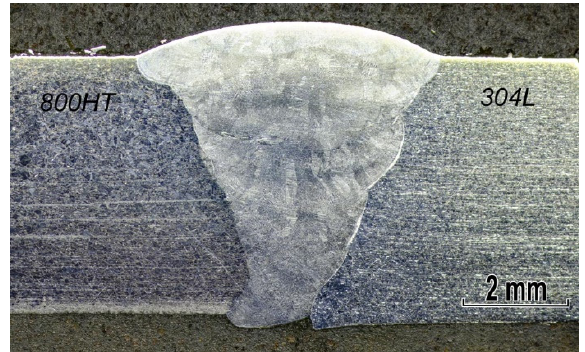
Figure 6. Cross-section of the Incoloy 800HT nickel alloy–304L austenitic stainless steel welded joint.